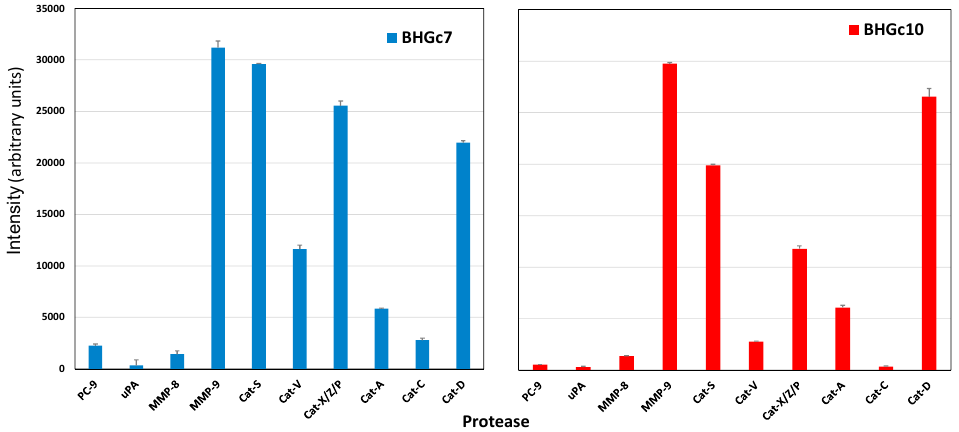
Figure 3 . Selected proteases expressed by BHGc7 (left side) and BHGc10 (right side) SCLC CTC lines, established from blood samples of two refractory SCLC patients, respectively. Values represent mean ± SD.